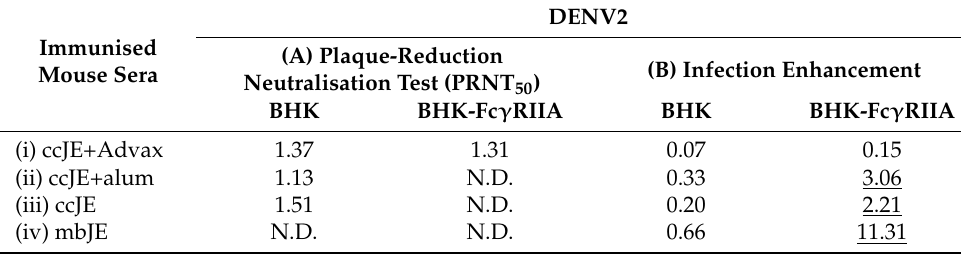
Table 3. ccJE with Advax induced neutralising antibody against DENV2 without triggering Fc γ receptor antibody-dependent infection enhancement (ADIE) activity. DENV2 Immunised (A) Plaque-Reduction Mouse Sera Neutralisation Test (PRNT 50